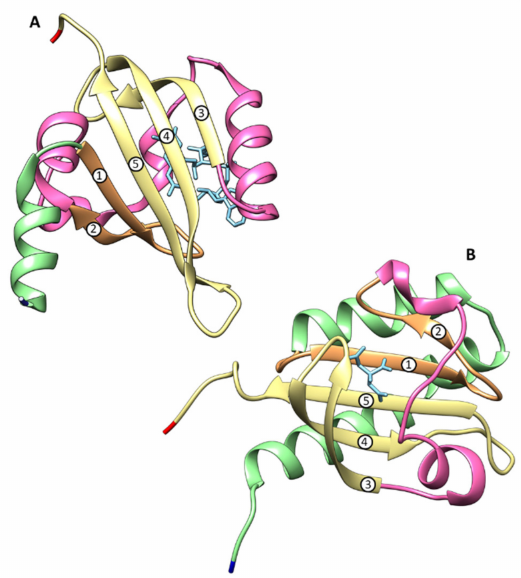
Figure 4. Representative structures of PAS ( A ) and sCache ( B ) domains. The first corresponds to the redox-sensing PAS domains of Azotobacter vinelandii NifL (PDB ID: 2GJ3) bound to FAD (flavin adenine dinucleotide) and the second to the ligand-binding domain of the Klebsiella pneumoniae ( K. pneumoniae ) sensor kinase CitA protein (PDB: 1P0Z). The core of β -strands are labeled with Arabic numbers. The structures were generated with CHIMERA [38] and are colored as follows: N-terminal end—dark blue; the first α -helix region—green; the β -strands 1 and 2—orange; the inter-domain α -helix region—pink; the β -strands 3 to 5—yellow and the C-terminal—red. FAD and citrate molecules are shown in light